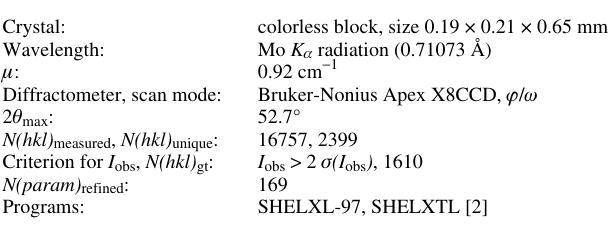
Table 1. Data collection and handling.